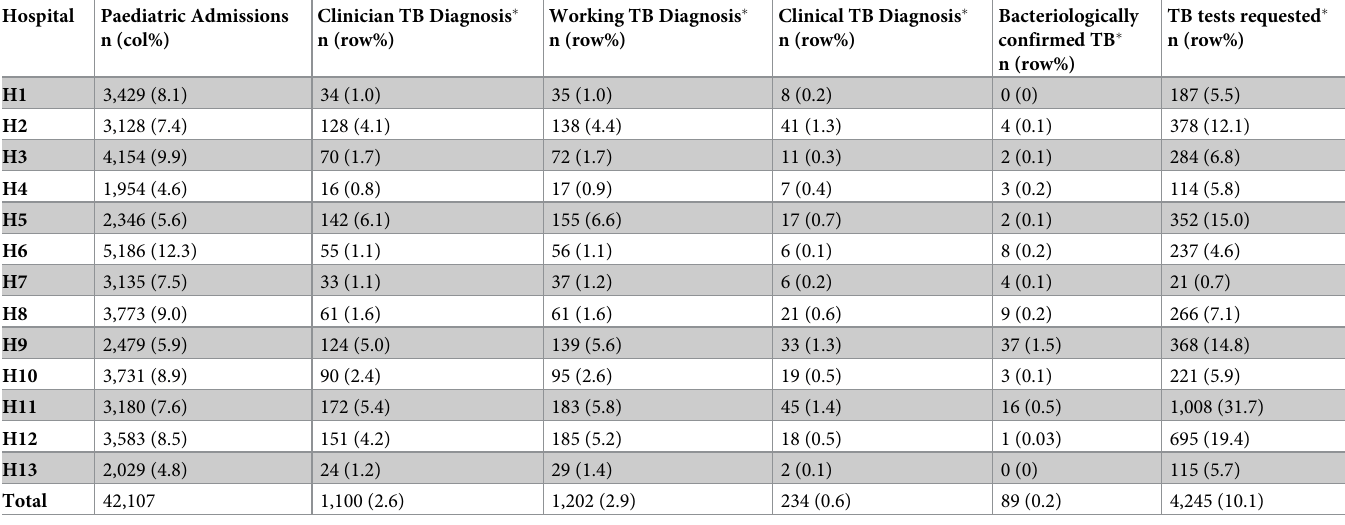
Table 4. Hospital level characteristics and estimated burden of TB amongst admissions over 24 calendar